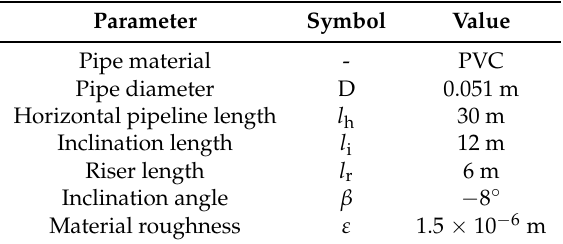
Table 1. Dimensions of the test facility pipeline.